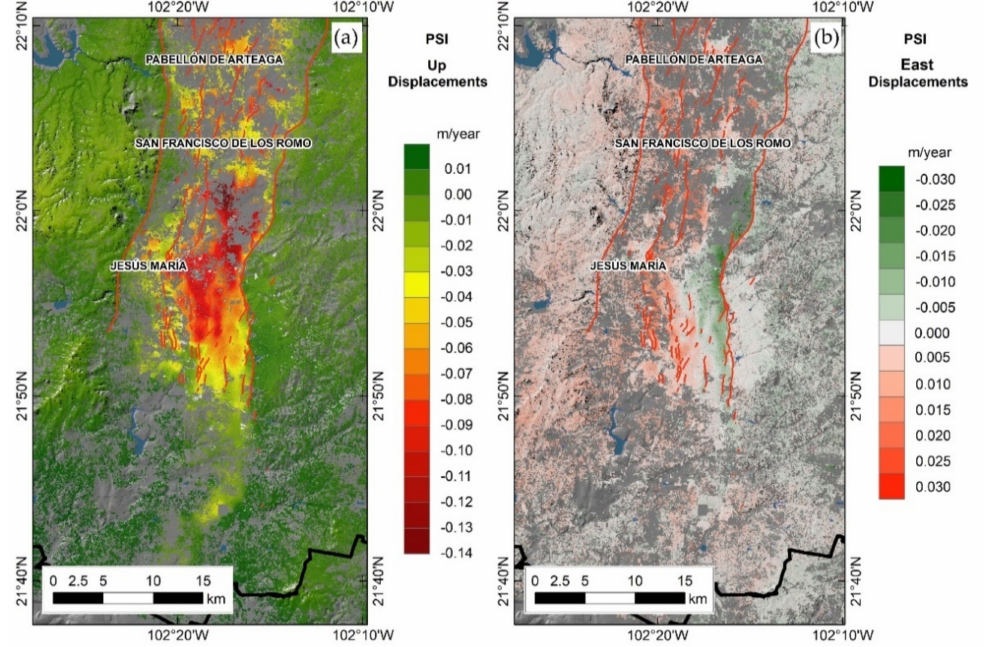
Figure 6. PSI results: displacement velocity in 2014 − 2016 along the ( a ) vertical V U and ( b ) east-west V E directions. V E larger than 0.03 m/year are dispersed outside the subsidence area. Both the SBAS and PSI output datasets clearly depict the land deformation pattern that affects the whole Aguascalientes Valley and is well-known from past InSAR